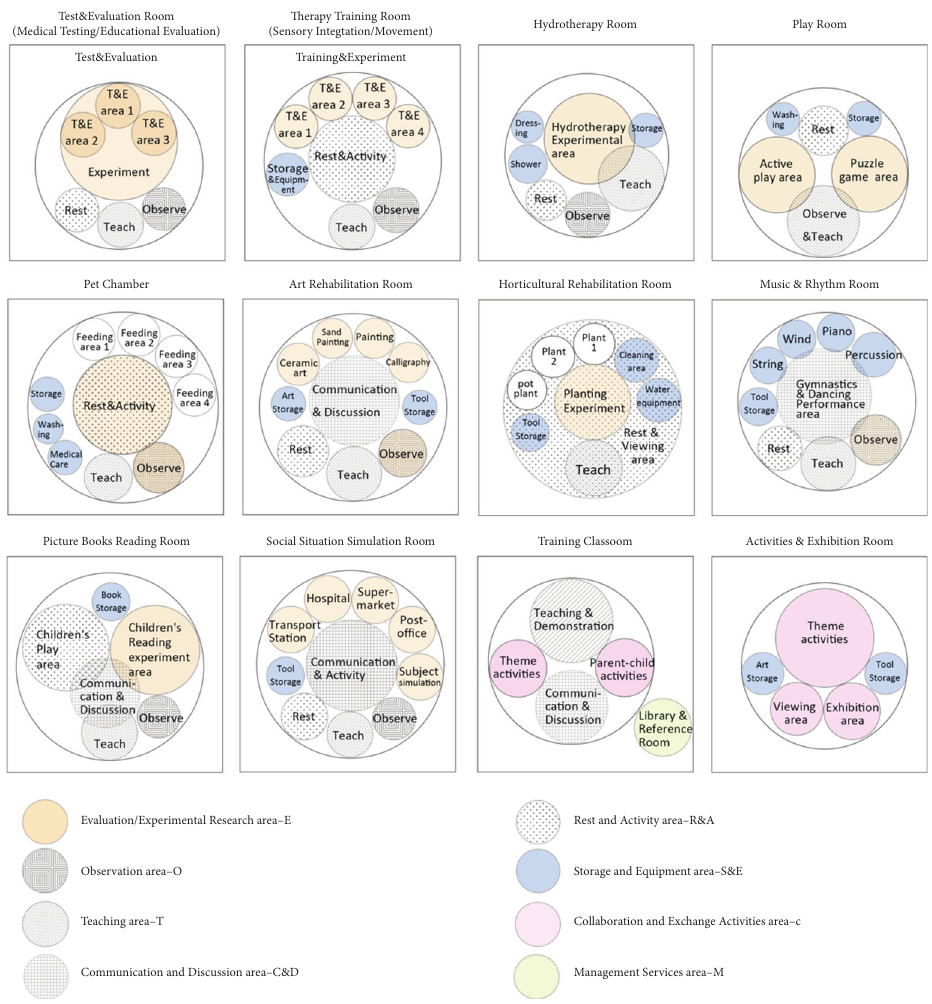
Figure 10: Space composition pattern of special function rooms.